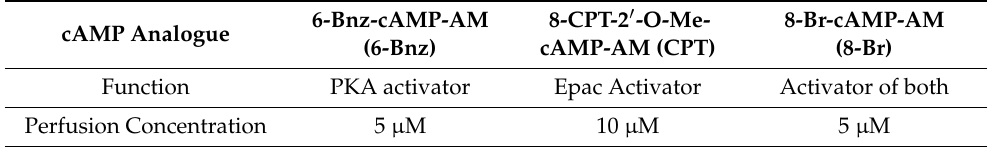
Table 1. List of cAMP analogues used in these studies. 6-Bnz-cAMP-AM cAMP Analogue (6-Bnz) Function PKA activator Epac Activator Activator of both Perfusion